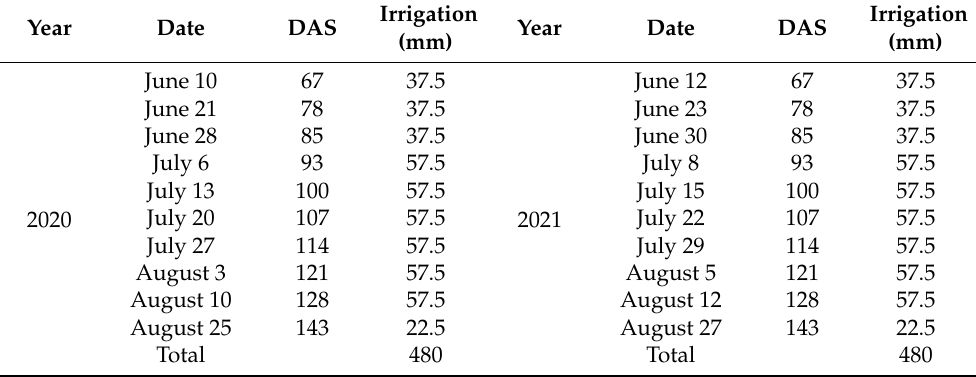
Table 1. Irrigation schedule for 2020 and 2021 growing